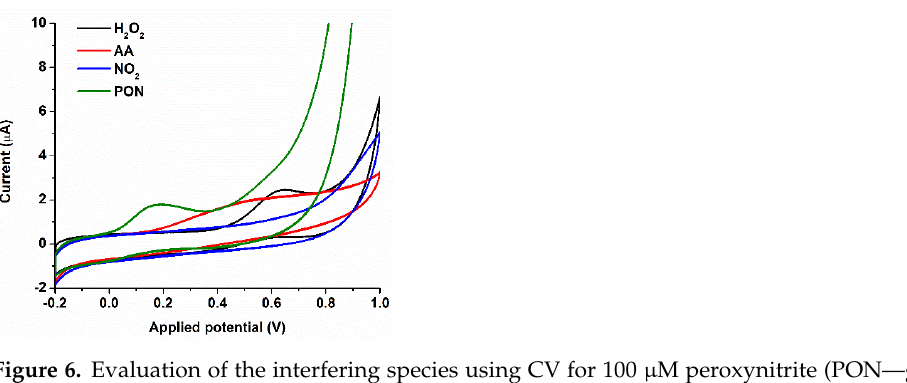
Figure 6. Evaluation of the interfering species using CV for 100 µ M peroxynitrite (PON—green): 100 µ M ascorbic acid (AA—red), 100 µ M hydrogen peroxide (H 2 O 2 —black), 100 µ M nitrite (NO 2 —blue), using a glassy carbon electrode (GCE)/CoPc electrode. Scan rate 100 mV/s, electrolyte: PBS pH 9 0.1 M + 0.1 M KCl [1].